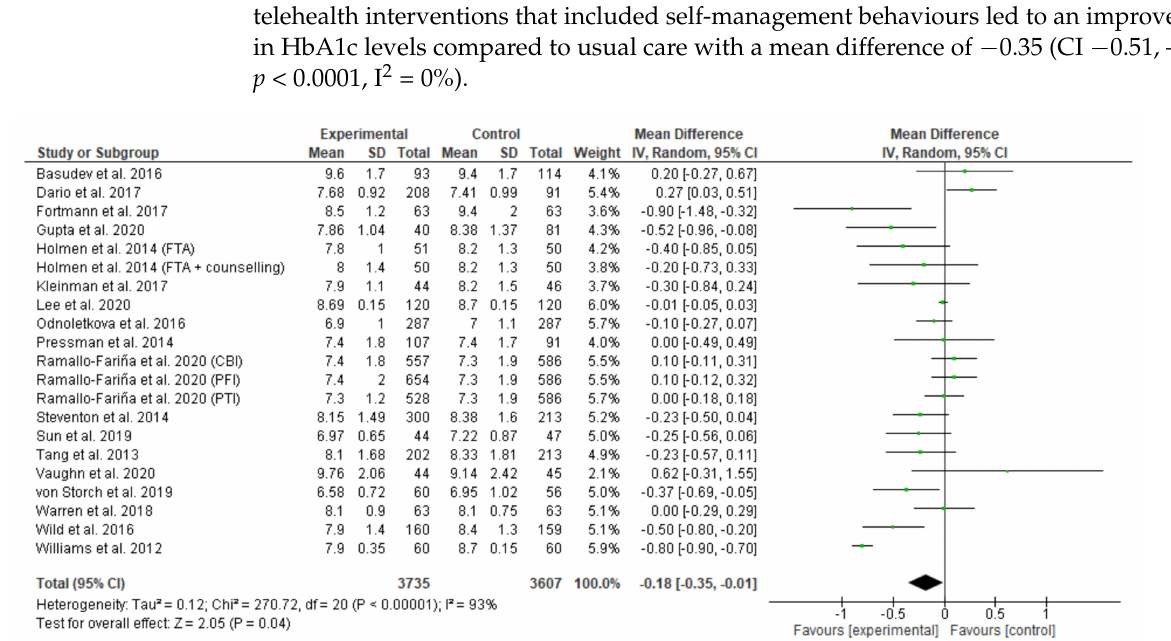
Figure 2. Mean HbA1c for all telehealth studies. BMI was used as a secondary outcome measure. Nine studies were included for the overall analysis which favoured usual care as opposed to telehealth interventions as a means to improve body mass index (BMI) amongst adults with type 2 diabetes. A random effects meta-analysis concluded that there was no statistical difference between the groups with a mean difference of 0.41 (CI − 0.47, 1.29), p = 0.36, I 2 = 65% (see Appendix B). Corresponding Forest plots for all the meta-analysis and subgroup analysis can be found in the Appendix (see Appendix